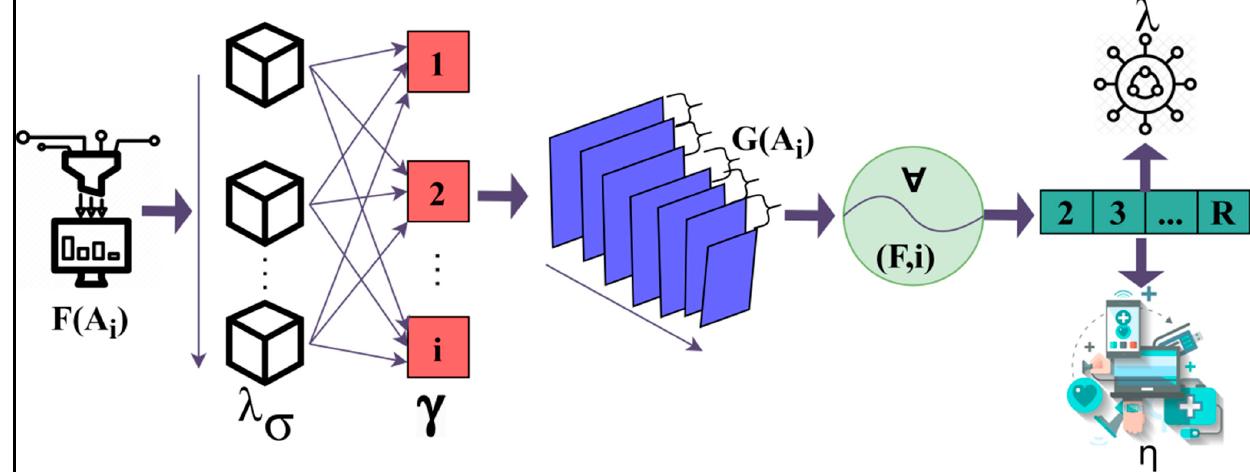
Figure 4. Learning for abnormalities.